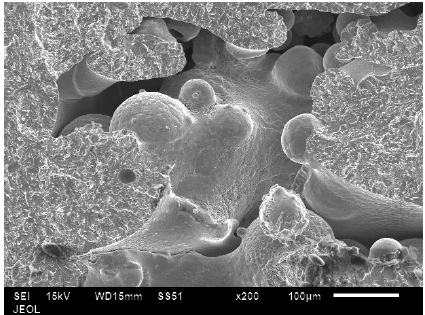
Figure 16. Unmelted powder particles seen on the tensile fracture surfaces of low energy samples.